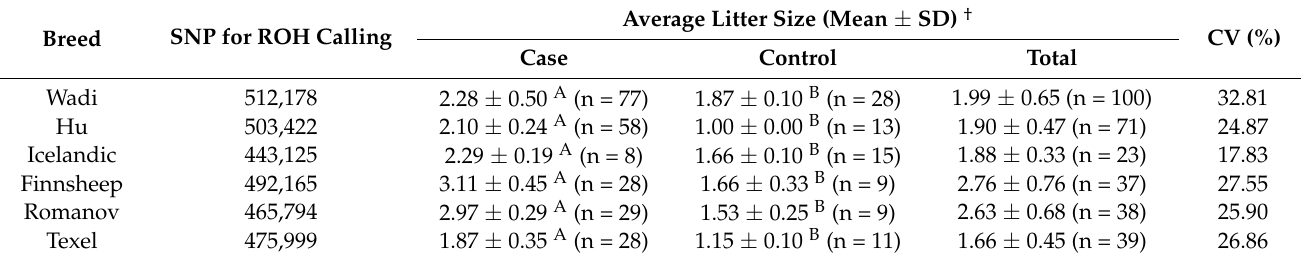
Table 1. Genotypes and phenotypes of six sheep